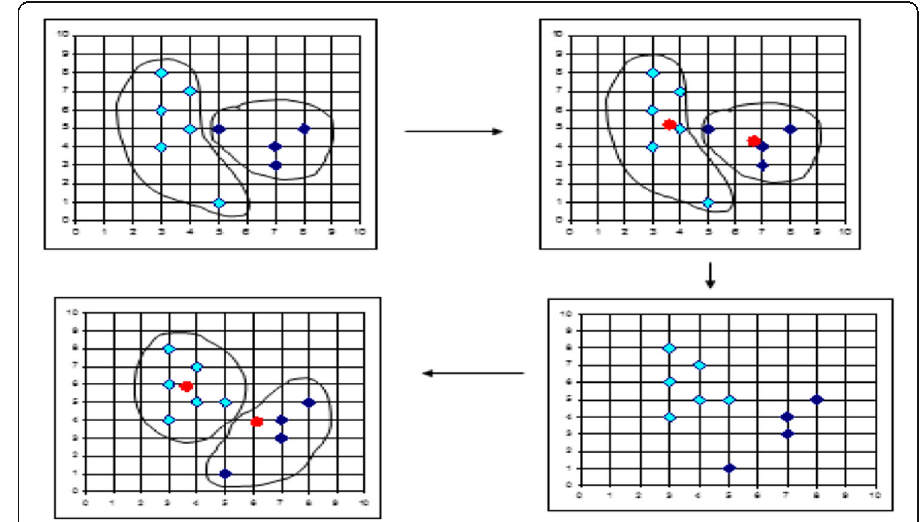
Fig. 3 Example of results k-means